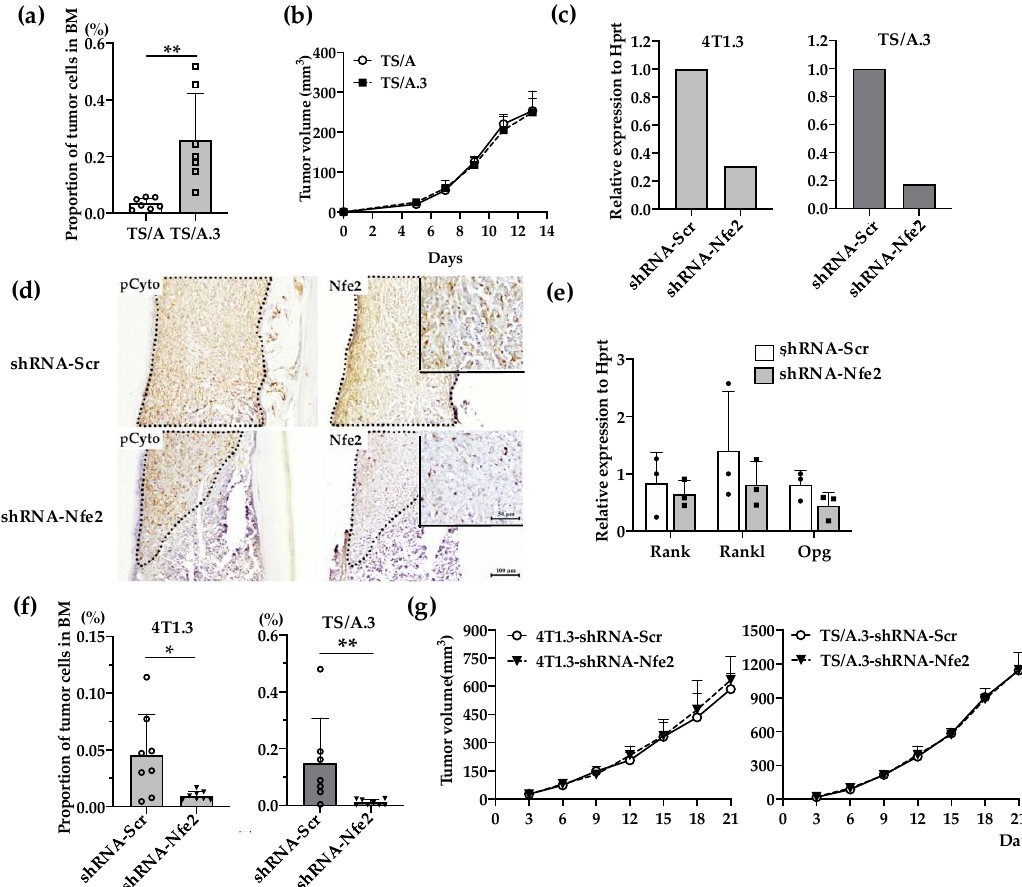
Figure 4. ( a ) Intraosseous injection of TS / A and TS / A.3 clones. Tibia was obtained from mice 9 days after intraosseous injection of TS / A or TS / A.3 cells and was subjected to flow cytometric analysis. The proportions of CD45 − CD24 − CD44 high tumor cells among total cells were determined as described in the Materials and Methods section. All values represent mean + SD ( n = 7). ** p < 0.01. ( b ) Tumor growth rates of TS / A and TS / A.3 cells upon their injection into mammary fat pads. TS / A or TS / A.3 cells (1.5 × 10 5 ) were injected into mammary fat pads and tumor growth was determined at the indicated time points. All values represent mean + SD ( n = 4). ( c ) Nfe2 expression level in Nfe2 shRNA-transfected 4T1.3 or TS / A.3 clones. Either 4T1.3 or TS / A.3 clones were transfected with Nfe2 or scrambled shRNA-expressing vectors. Total RNAs were extracted from the resultant transfectants and were subjected to qRT-PCR to quantify Nfe2 mRNA. ( d ) Immunohistochemical analysis of Nfe2